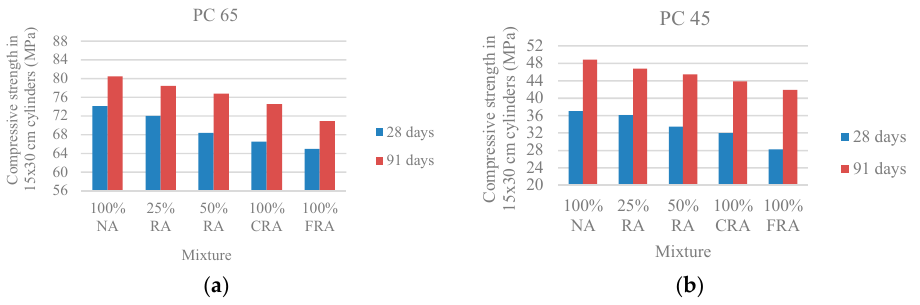
Figure 4. ( a ) Compressive strength in cylinders at 28 and 91 days (PC 65); ( b ) Compressive strength in cylinders at 28 and 91 days (PC 45).